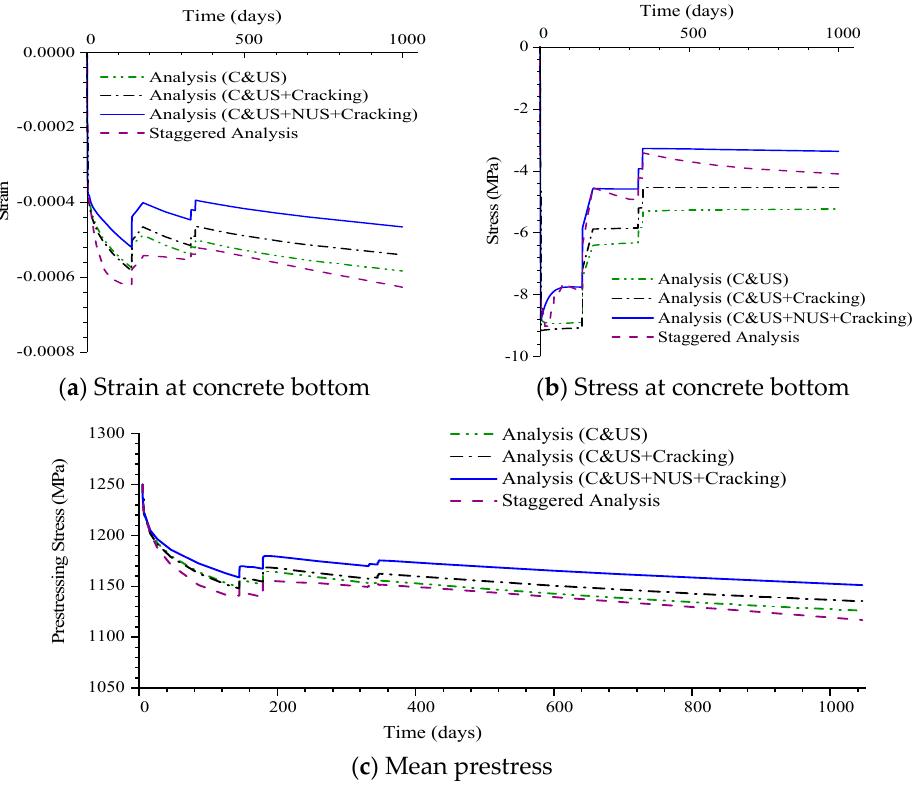
Figure 15. Variation of strain and stress of concrete bottom and mean prestress at the mid-span section with time in the medium-span PSC box girder.